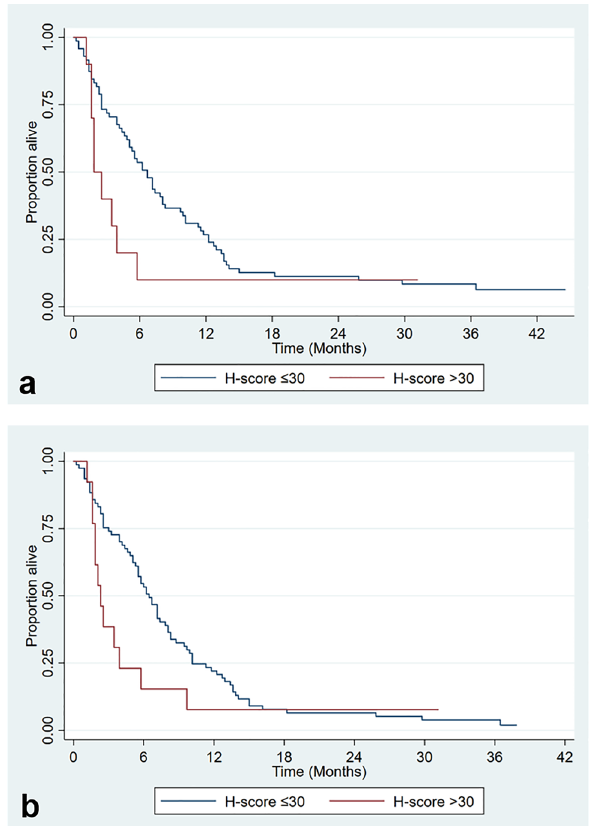
Figure 2. Kaplan–Meier plot of survival times by FNB p40 H-score in ( a ) inoperable patients, ( b ) non-resected